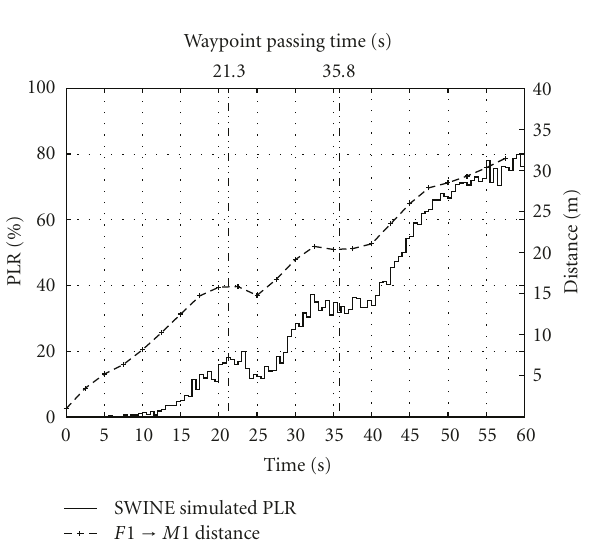
Figure 13: Live test PLR measure.